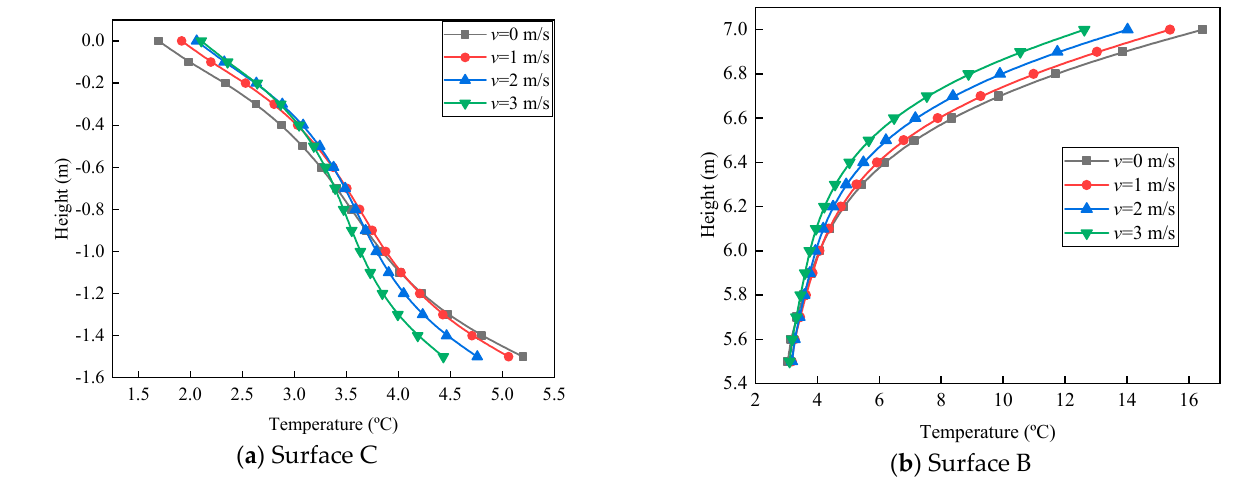
Figure 21. Temperature gradients with different wind speeds. The change of geographic latitude will affect the angle of incidence. Several simula- tions with different latitudes within ±5° in latitude from the original location have been made, and results are shown in Figure 22. The maximum temperature change on surface B is 15.7% (at 36°), and that on surface C is less than 9.1% (at 36°). The maximum temperature change rates per degree in latitude are about 3.77% on surface B and 2.19% on surface C, which indicates that the effect of latitude change on the temperature field of the aqueduct is limited.